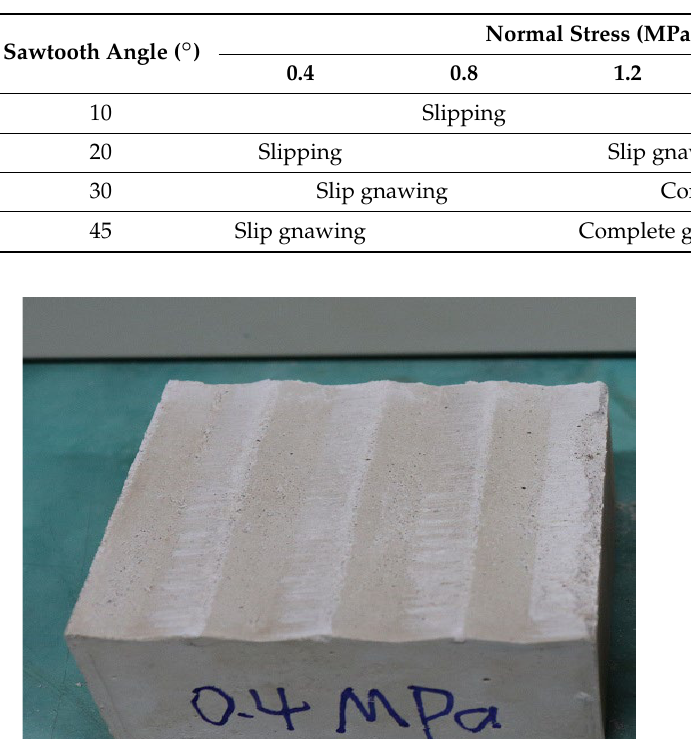
Table 3. Failure mode statistics of sawtooth joints.